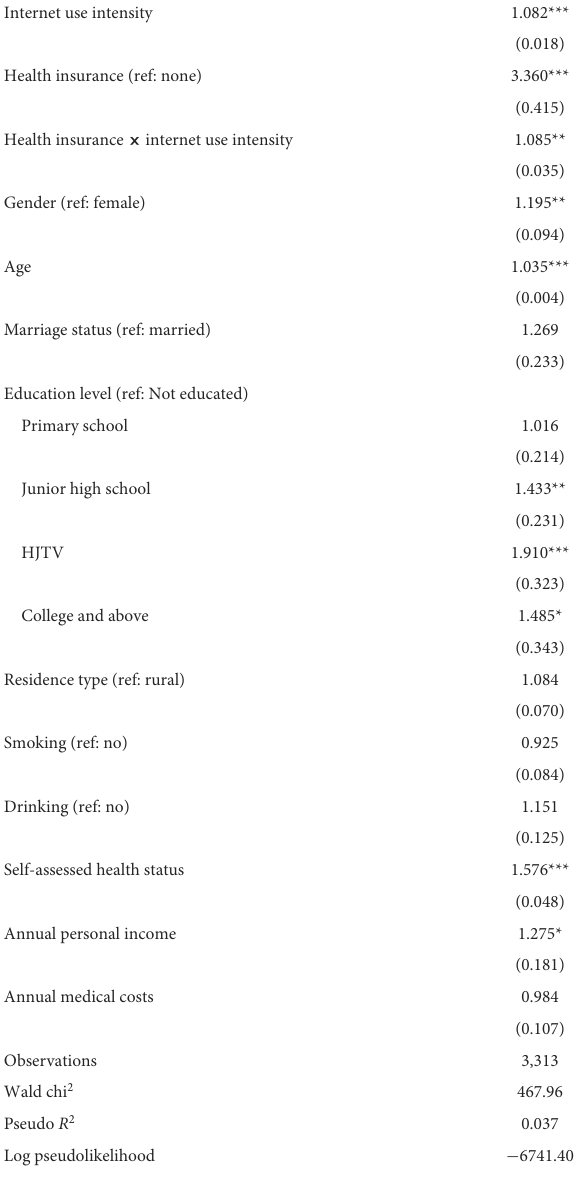
TABLE 6 Regression results of the moderating effect for health insurance ( N =